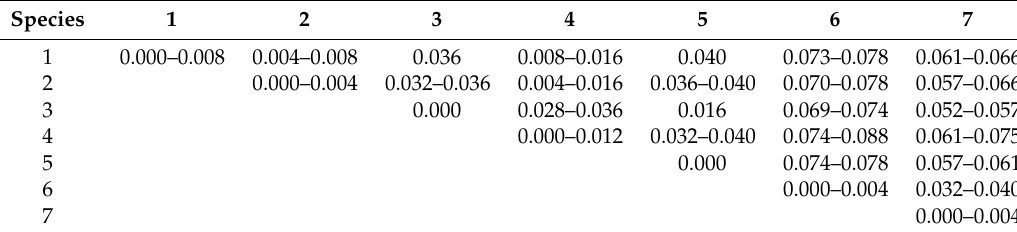
Table 3. Intra- and inter-specific K2P distance of Shi-Liang tea and its closely related species.